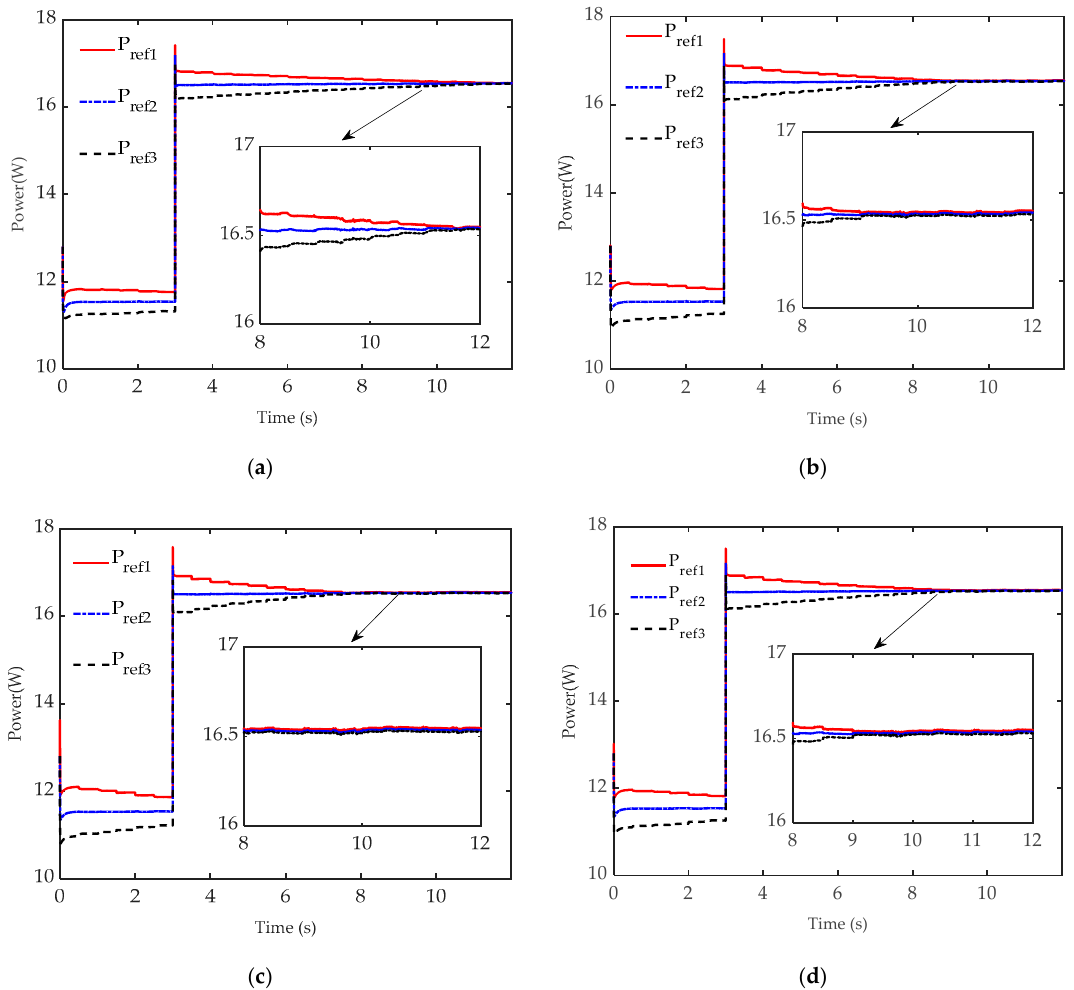
= 2; ( b ) g = 3; ( c ) g = 4; ( d ) K =